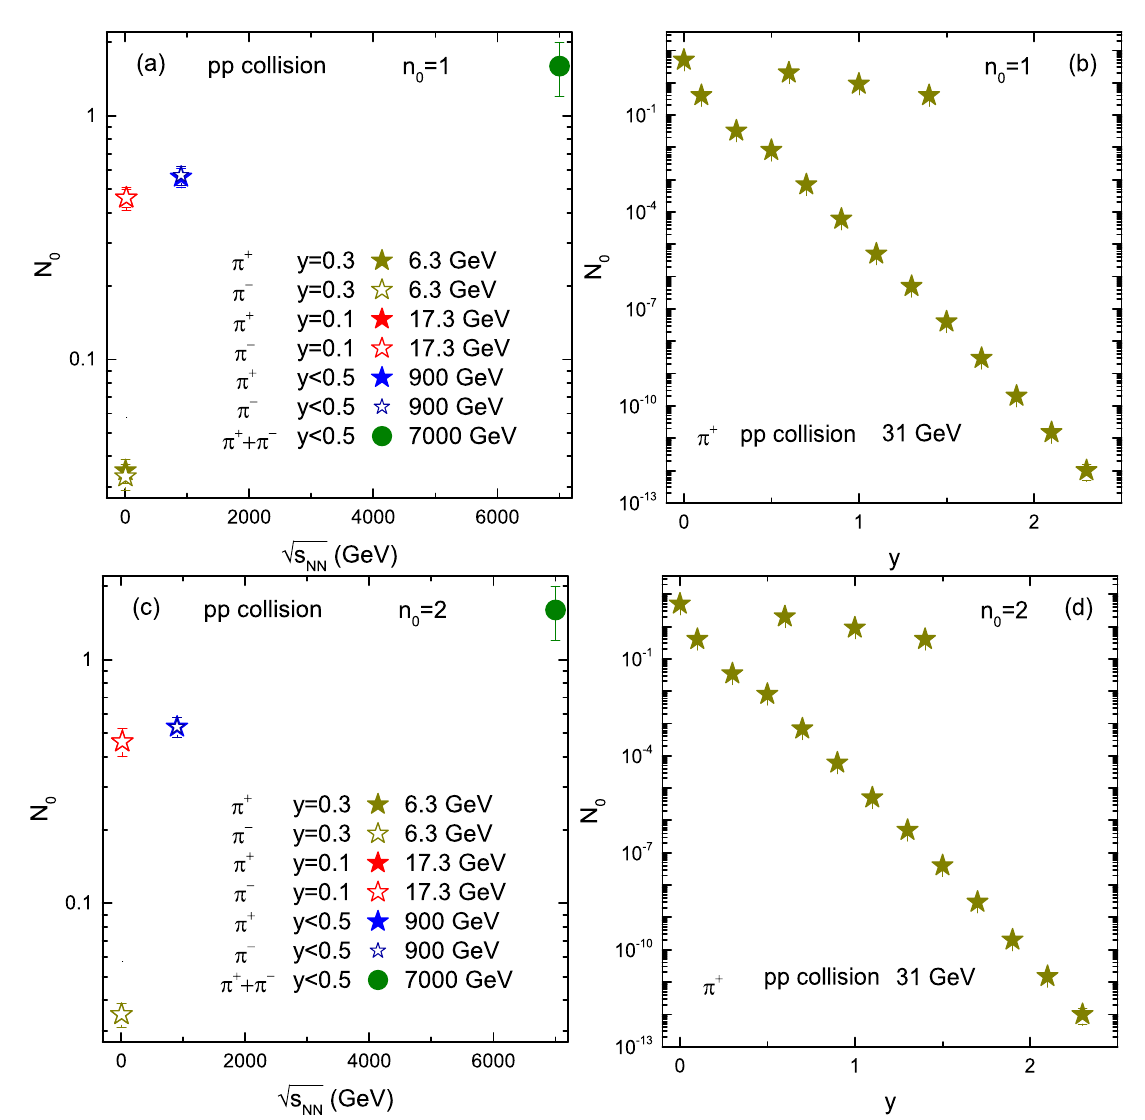
Figure 6. Dependence of the multiplicity parameter N 0 on collision energy as well as rapidity at 31 GeV. Panels ( a , c ) show the dependence of N 0 on collision energy by using the flow profile n 0 = 1 and 2, respectively, in the TBW model, while panels ( b , d ) show its dependence on rapidity at 31